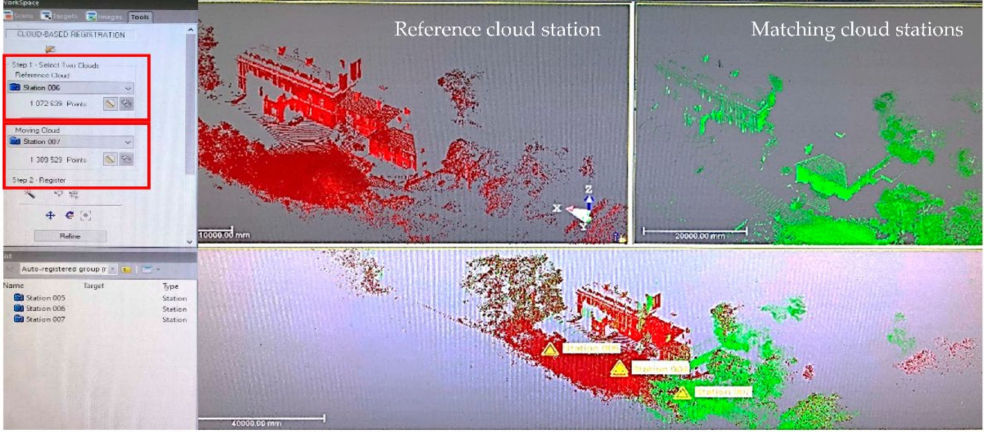
Figure 8. Manual registration process.